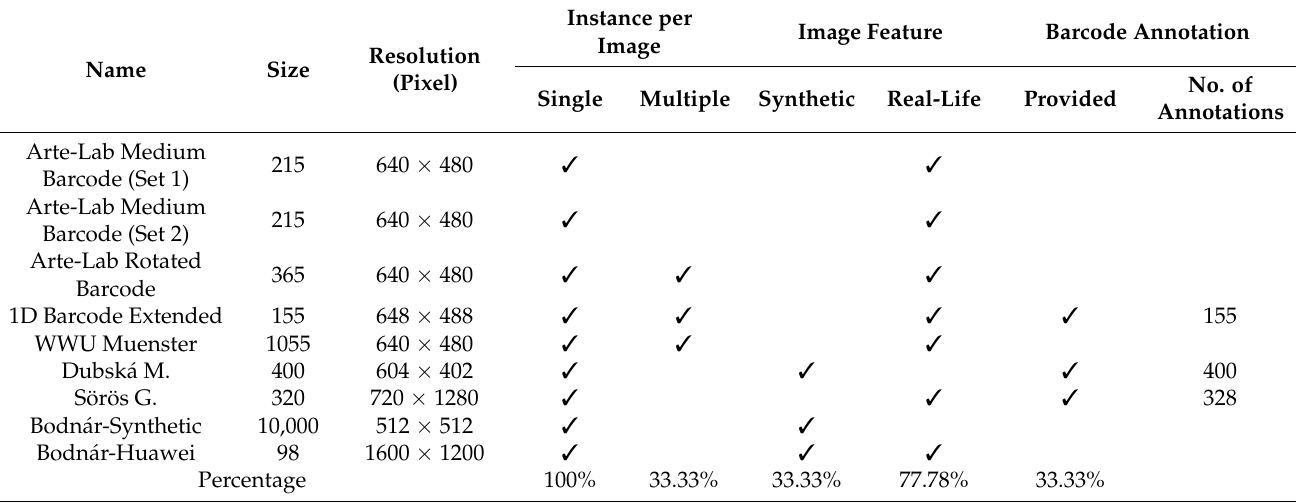
Table 1. Current publicly available barcode